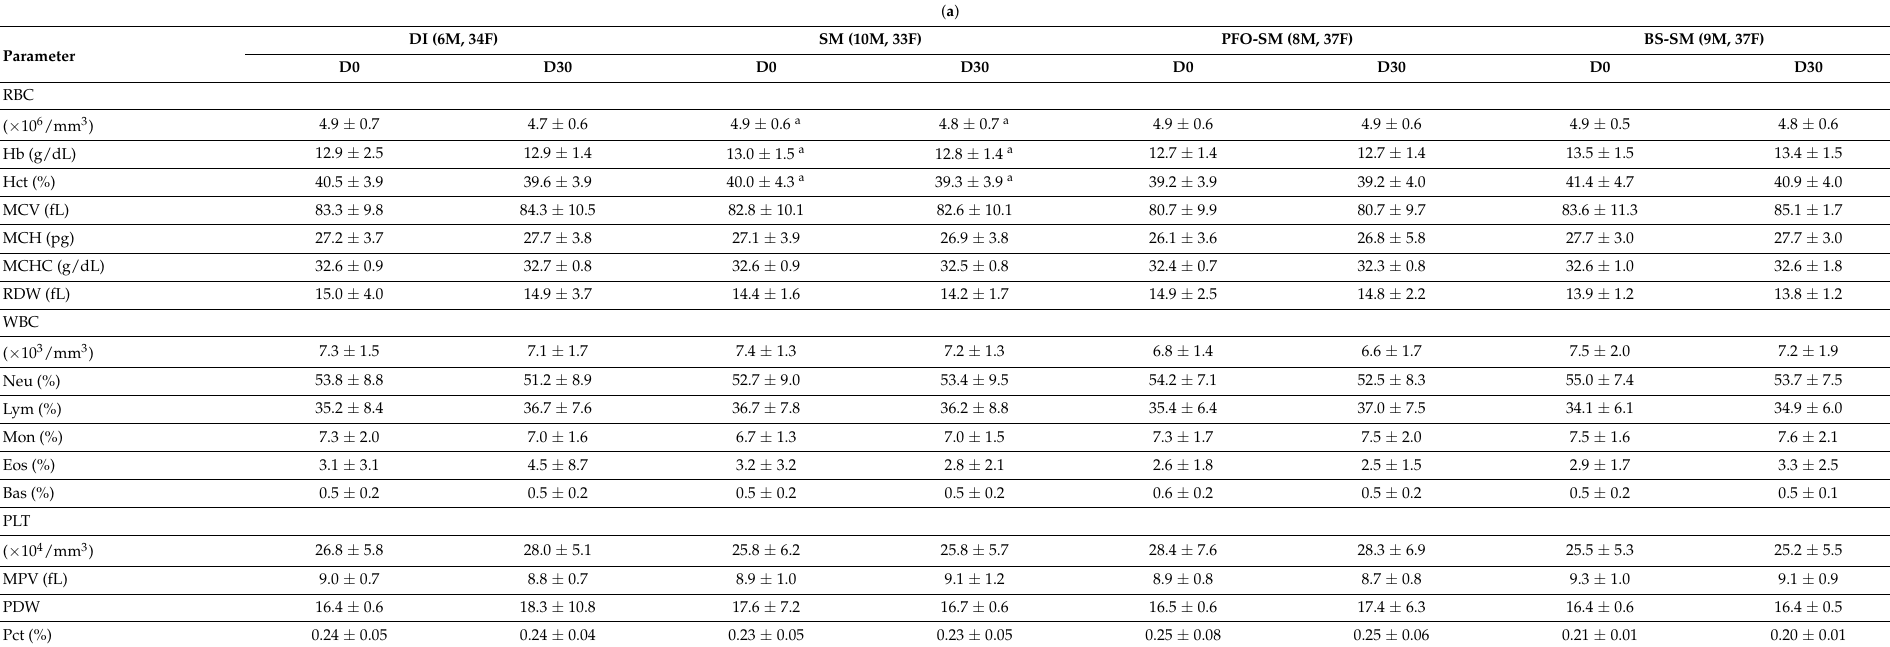
Table 5. ( a ) Complete blood count values of subjects who received drinks for 30 days. RBC, WBC, and platelet indices. Data are expressed as mean ± SD values. Accordingly, a p values of <0.05 were considered significant when compared with the baseline (D0) data of the same group using the parametric paired Student’s t -test. b ( b ). Complete blood count values of male and female subjects who received drinks for 30 days. RBC, WBC, and platelet indices. Data are expressed as mean ± SD values of total subjects, as well as for female and male subjects. Accordingly, e p values of <0.05 were considered significant when comparisons were made between male and female subjects in the same group and at the same time using a parametric independent sample of the Student’s t -test; f p values of <0.05 were considered significant when comparisons were made between male and female subjects in the same group and at the same time using non-parametric Mann-Whitney U test; g p values of <0.05 were considered significant when comparisons were made between value changes in the same gender following consumption of the drinks using non-parametric Mann-Whitney U